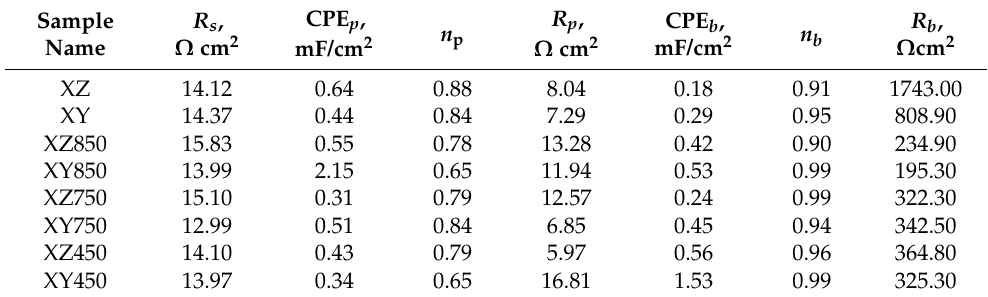
Table 4. Fitted data for parameter of equivalent circuit.